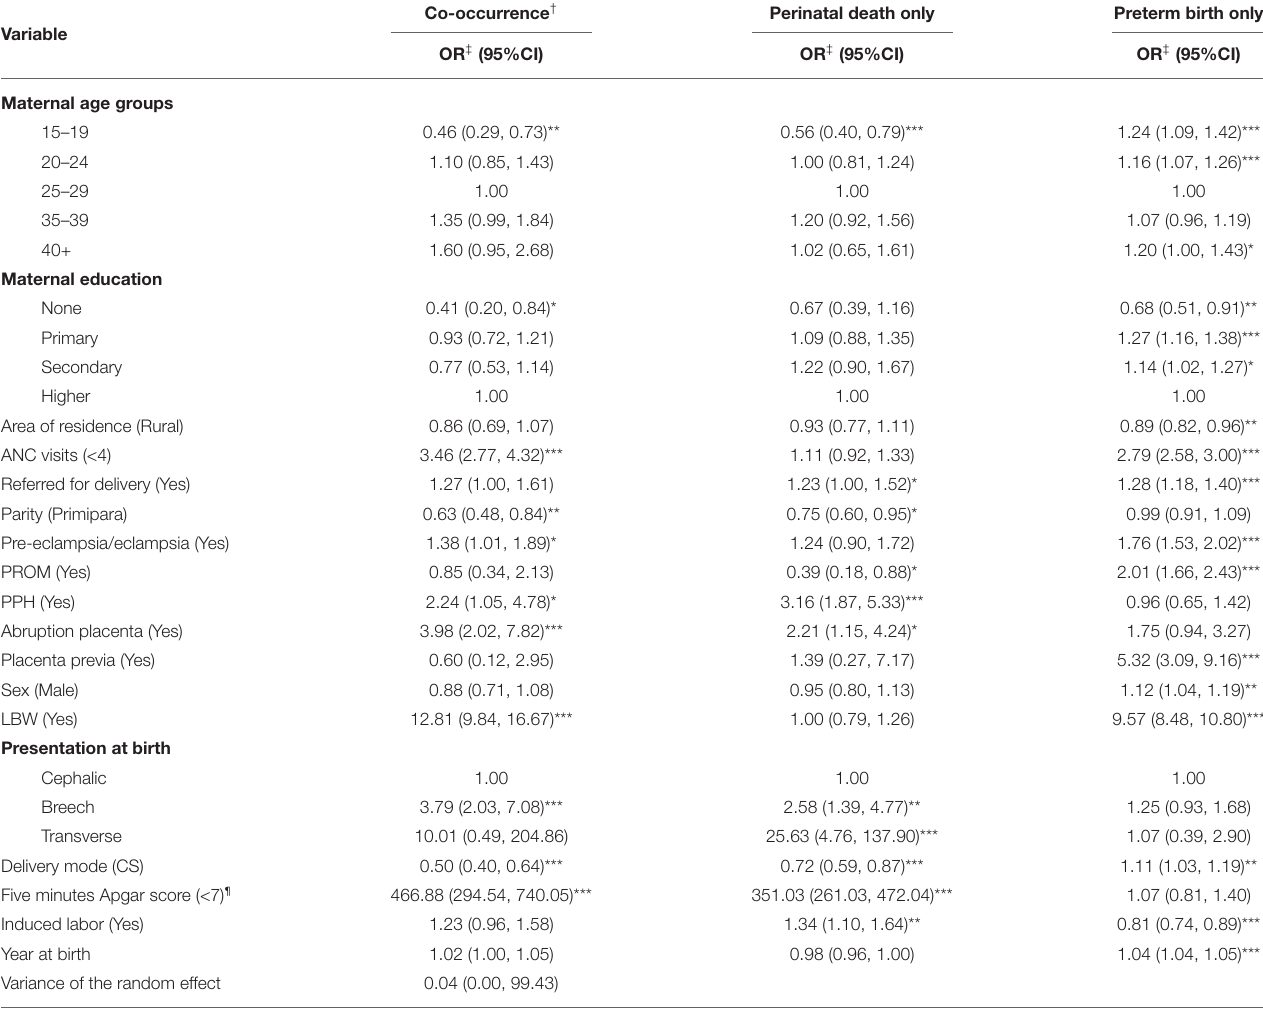
TABLE 4 | Predictors of independent and co-occurrence of preterm birth and perinatal death using random effect multinomial regression model ( N =